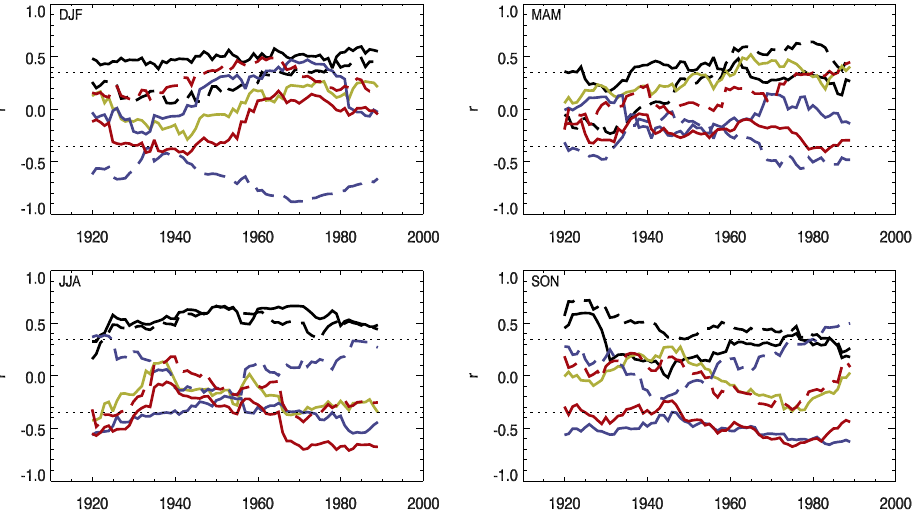
Fig. 6. Running 30-yr correlations between pairs of seasonal indices representing the drivers of inter-annual climate variability in the MDB. SAM and STR intensity (solid black line), SAM and STR latitude (dashed black line), SAM and ENSO (solid yellow line), ENSO and IOD (solid blue line), ENSO and the eastern pole of the IOD (dashed blue line), ENSO and STR intensity (solid red line), and ENSO and STR latitude (dashed red line) are shown. A t -distribution with a sample size of 30yr was used to estimate the bounds of statistical significance and is indicated by the thin dashed lines ( t = ±